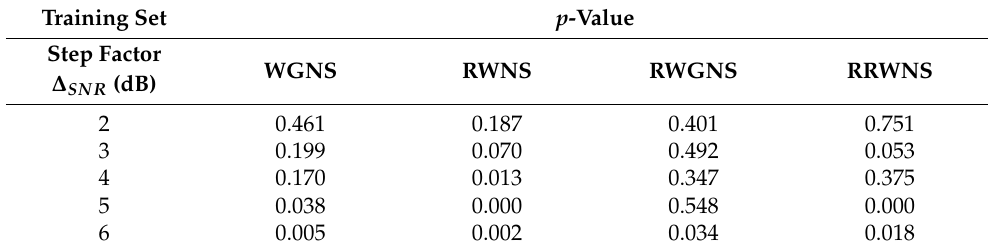
Table 5. P-value for some model results from Table 4.